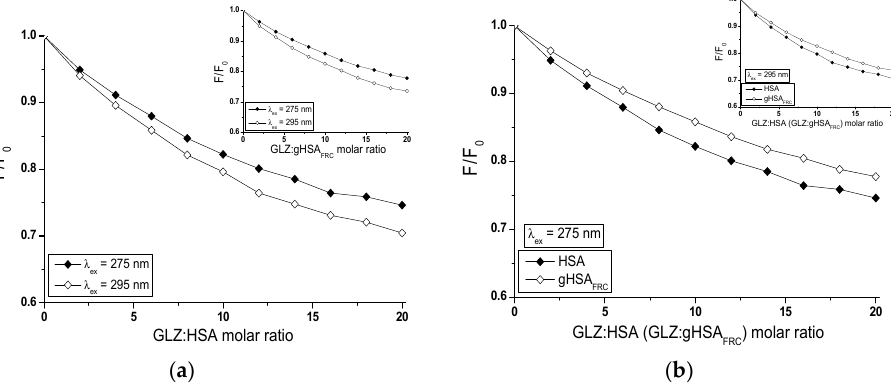
Figure 6. Fluorescence quenching of nonglycated (HSA) and glycated (gHSA FRC ) human serum albumin complexed with GLZ (4 × 10 − 6 mol · L − 1 –4 × 10 − 5 mol · L − 1 ). The albumin concentration was 2 × 10 − 6 mol · L − 1 ; ( a ) GLZ-HSA (in the main view) and GLZ-gHSA FRC (in the insert) and ( b ) λ ex = 275 nm (in the main view) and λ ex = 295 nm (in the insert); the error bars are smaller than the symbols.